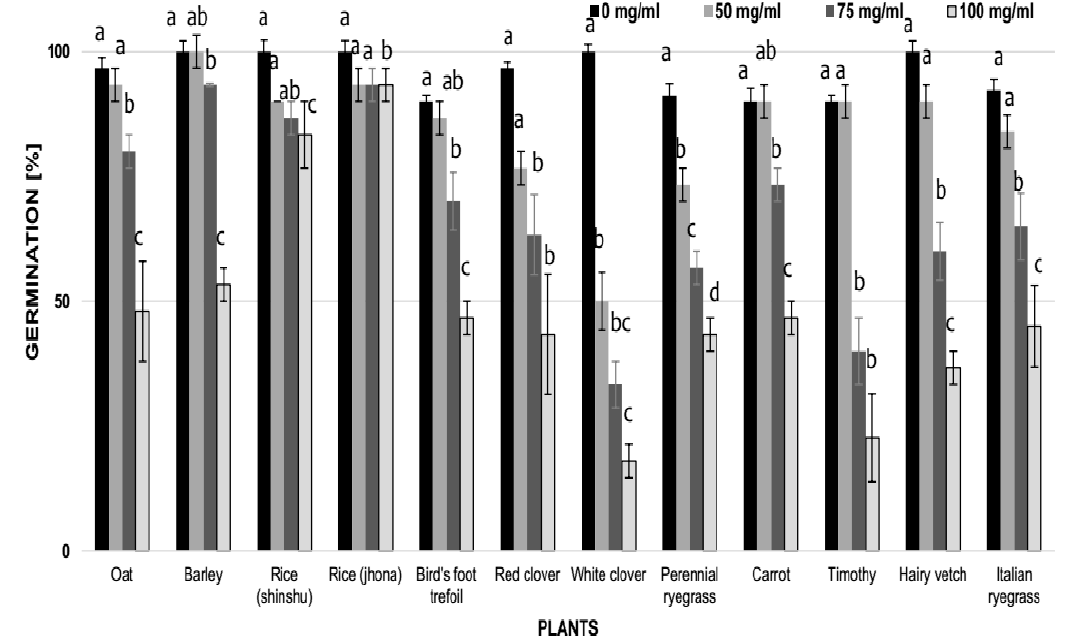
Figure 2. The effect of Vinatea-green tea extract on the germination of crops and weeds. Columns followed by the same letter, within the same crop or weed, are not significantly different ( p < 0.05, Tukey and Dunnett test). The data are the mean of three replications ± SD.